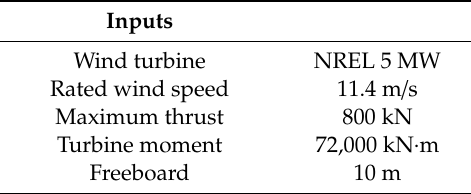
Table 4. Design constants for the optimization process.